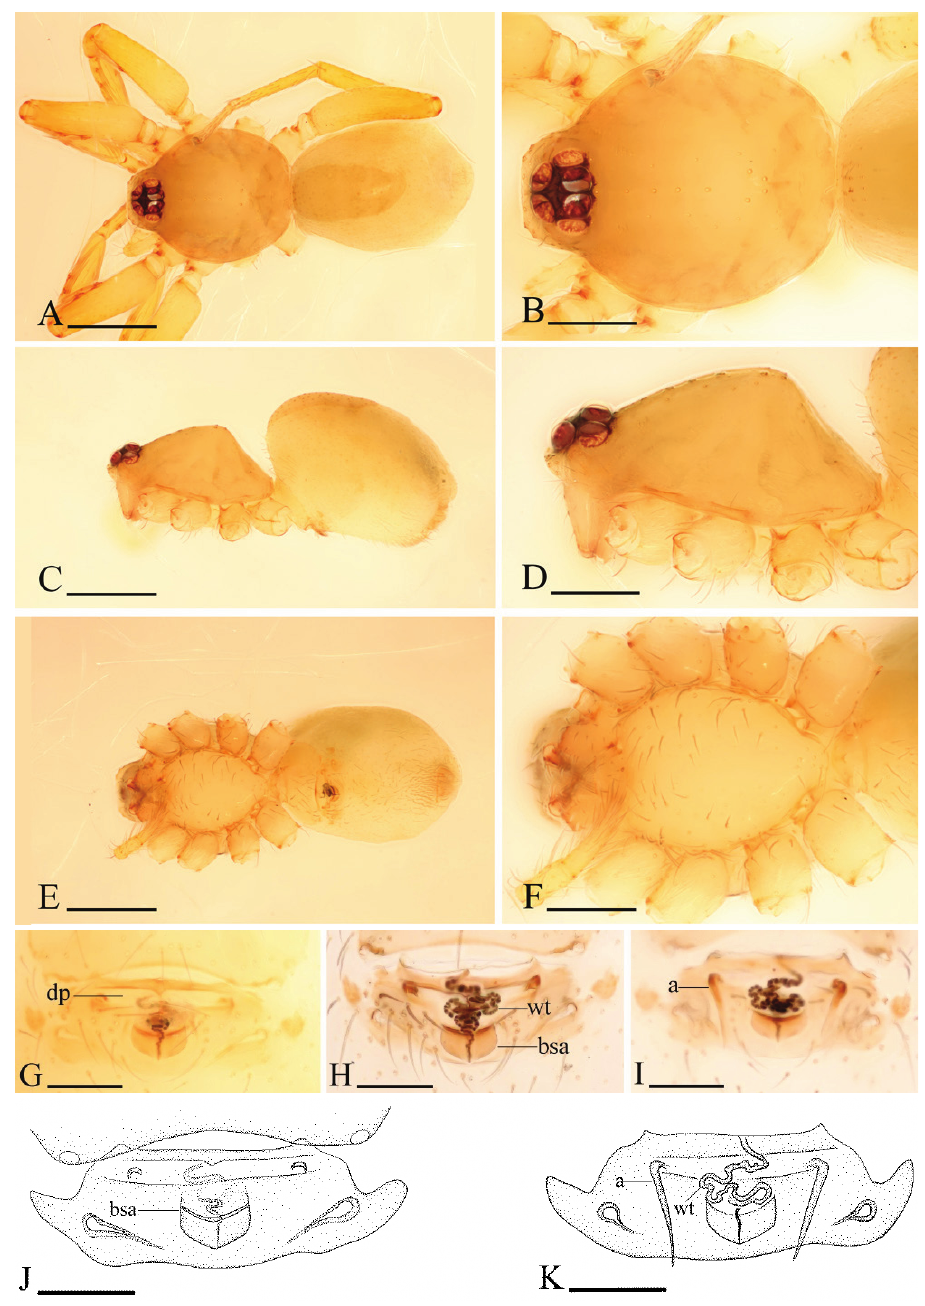
Figure 11. Ischnothyreus poculum sp. n., female. A, C, E habitus, dorsal, lateral and ventral views B, D, F prosoma, dorsal, lateral and ventral views G, H, J epigastric region, ventral view I, K epigastric region, dorsal view (H, I cleared in lactic acid). Abbreviations: a = apodeme; bsa = bowl-shaped atrium; dp = depression; wt = winding tube. Scale bars: A, C, E = 0.4 mm; B, D, F = 0.2 mm; G–K = 0.1